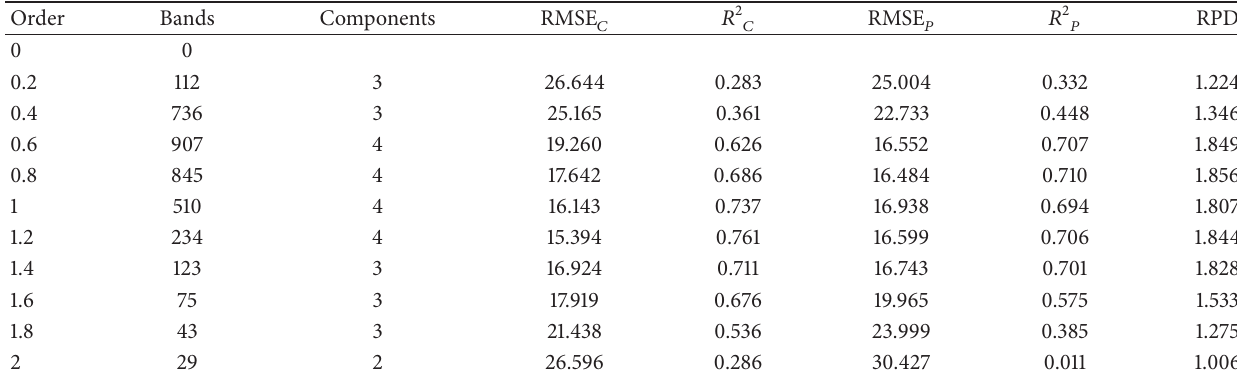
Table 2: The results of the models based on raw reflectance.